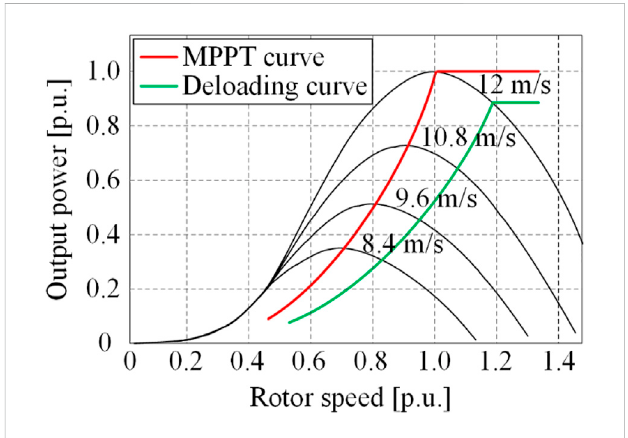
FIGURE 1 Wind turbine characteristics for normal and deloading operating modes (Ducar et al.,